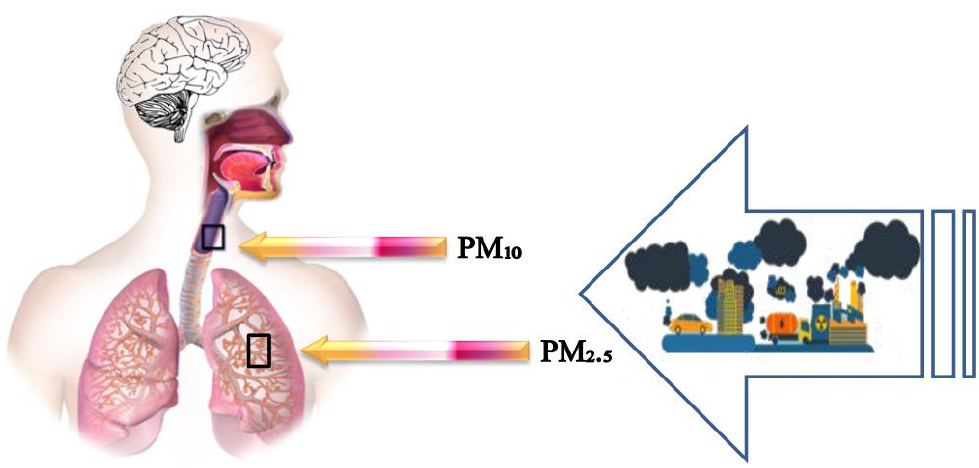
Figure 5. Comparison of breathing penetration of PM 2.5 and PM 10 into the human lungs. In China, Zhu et al. [31] examined the association of PM 2.5 , PM 10, and other contami- nants in 120 cities and reported COVID-19 daily cases. Significant positive associations of these contaminants with reported COVID-19 cases have been identified. The findings of this study support that COVID-19 infection can be caused by ambient air pollution. In contrast, in the health emergency in Lombardy (Italy) several days earlier, from 10 Febru- ary to 27 March 2020, Bontempi [32] first analyzed the PM 10 situation. The data on PM 10